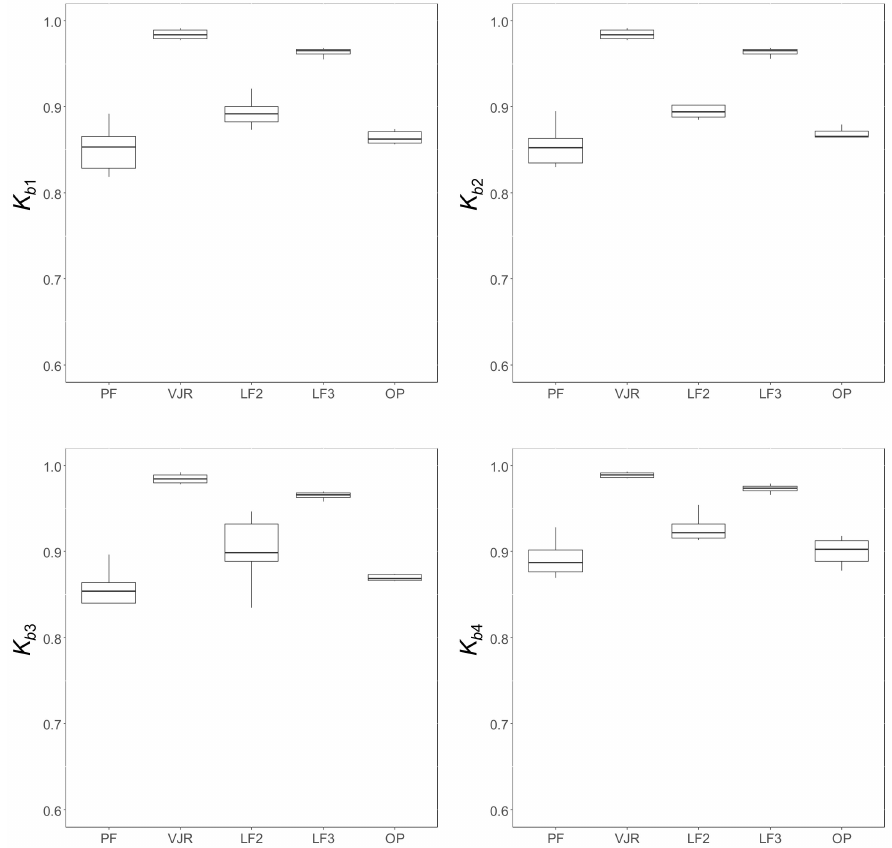
Figure 5. K b 1 , K b 2 , K b 3 , and K b 4 in the different land-uses.